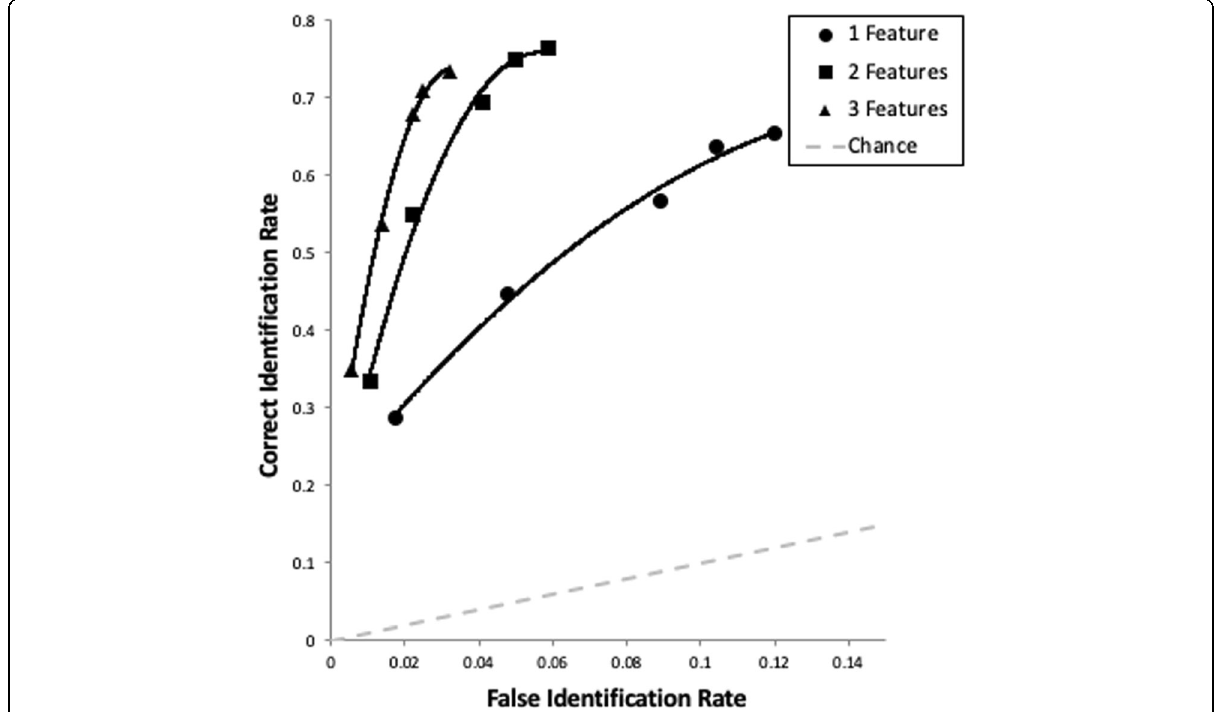
Fig. 2 ROC data from Experiment 1. The curves drawn through the empirical data points are not based on model fits, but rather are simple trendlines drawn in Excel. The correct ID rate on the y axis is the proportion of targets chosen from the total number of target-present lineups in a given condition. The false ID rate on the x axis is the proportion of all filler identifications from the total number of target-absent lineups in a given condition (as we had no designated innocent suspects), divided by the nominal lineup size (six) to provide an estimated innocent suspect ID